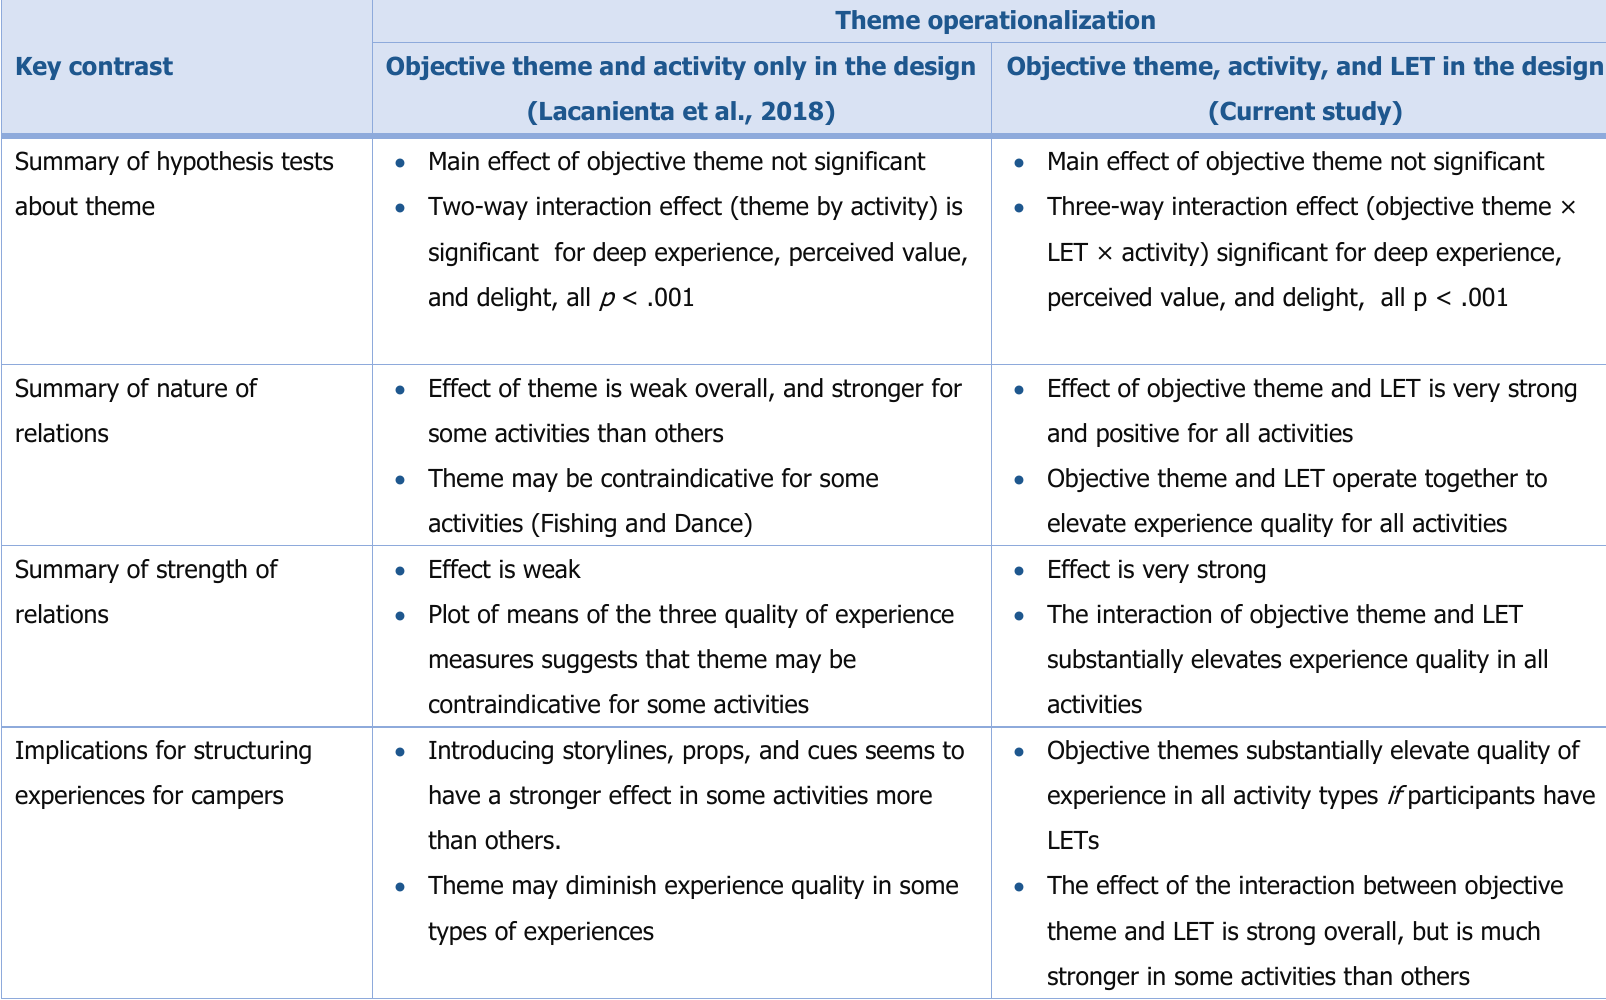
Table 2. Contrast of Results and Conclusions for Two